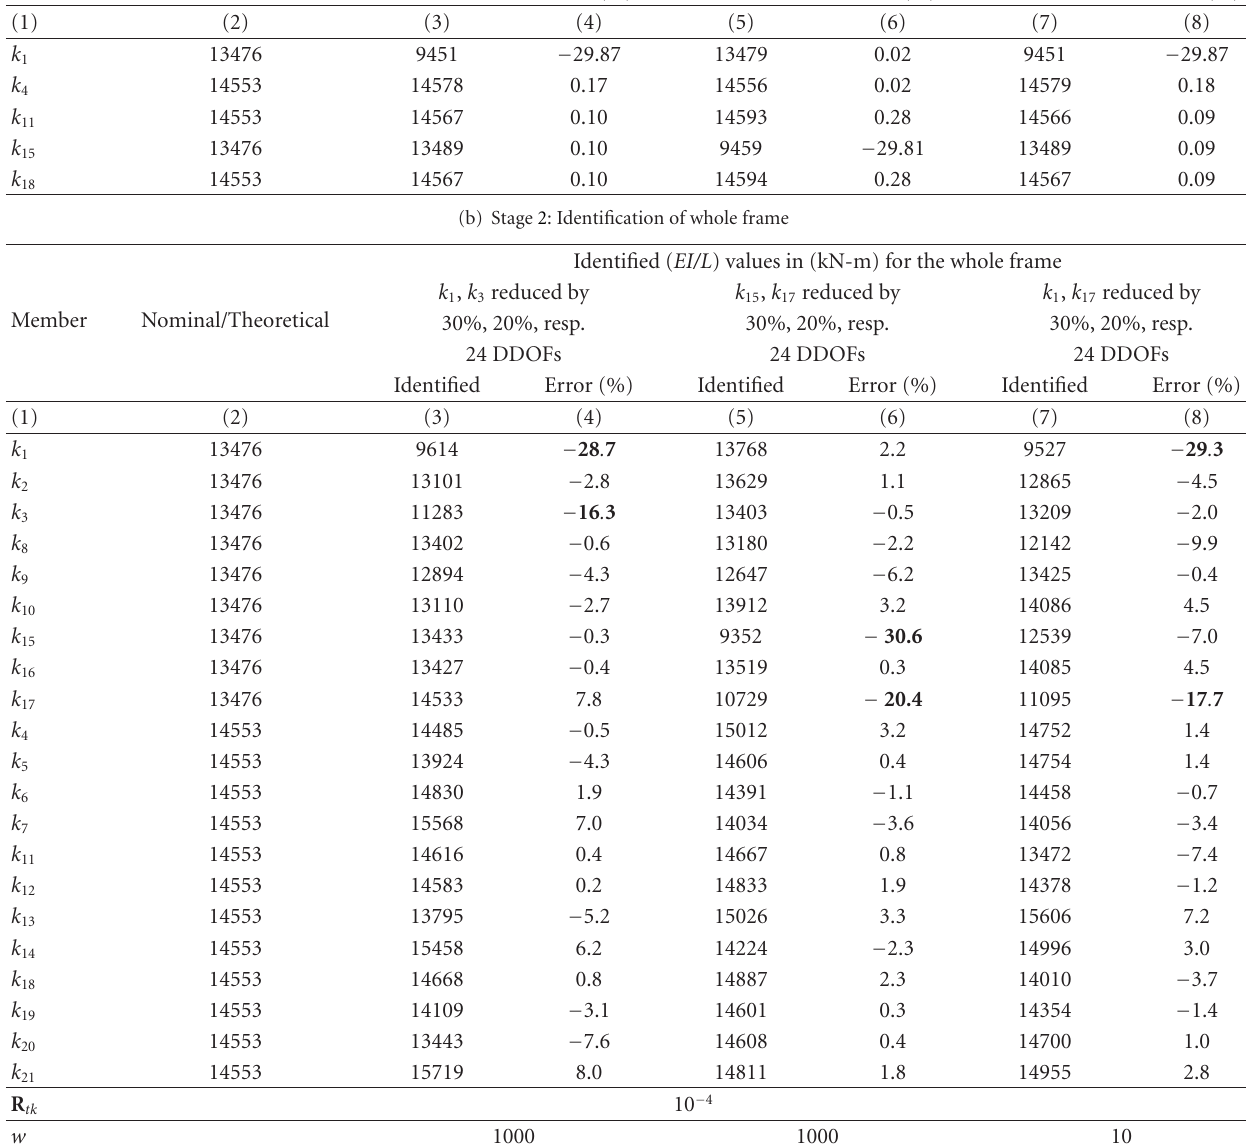
Table 4(b) for the whole structure. The sti ff ness parameter for member 16 is reduced by the maximum amount of 13.8%, significantly more than other members, indicating that it is defective. It can be concluded that the GILS-EKF-UI method successfully located the less severe defective